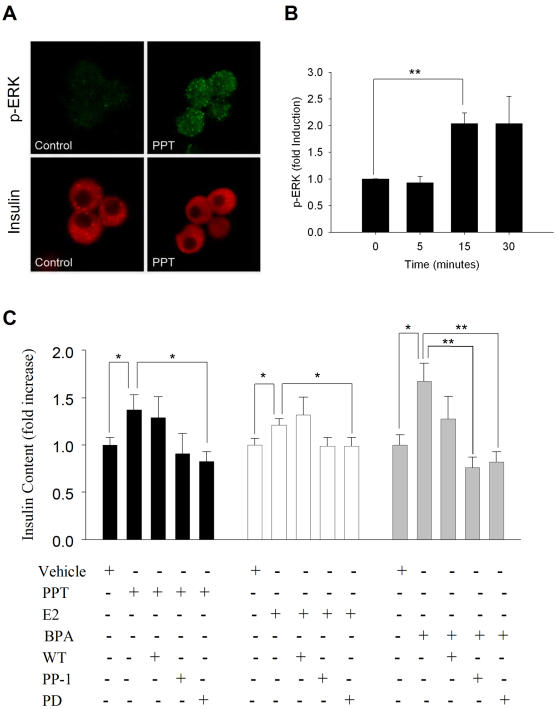
Implication of ERK1/2 in ERα action.A) Levels of ERK1/2 activation. Isolated β-cells were treated with the ERα specific agonist PPT for 0 (Control), 5, 15 and 30 min (PPT). Cells were fixed, permeabilized and incubated with antibodies to phospho-ERK1/2 (in green, p-ERK) and to insulin (in red, Insulin). Fluorescence images were registered with a confocal laser microscopy system. (B) Fluorescence intensity per cell was quantified as described in Materials and Methods. The histogram shows the fold increase in fluorescence intensity with respect to control (0 min). Data are pooled from 4 different experiments. Fluorescence intensity was obtained from at least 200 cells per condition in each experiment. *p = 0.01 Student's t-test comparing with column at 0 min. (C) Insulin content obtained in cultured islets exposed to either vehicle or 1 nM PPT (black columns), E2 (white columns) and BPA (grey columns) in the presence of the PI3Kinase inhibitor wortmannin (100 nM), the c-Src inhibitor PP-1 (10 µM) and the ERK1/2 inhibitor PD98059 (10 µM). Data were obtained from at least 4 independent experiments in duplicate using islets from at least 7 different mice. Data are expressed as fold change as compared to vehicle. *p<0.05, **p<0.01 Student's t-test comparing pairs marked by lines.